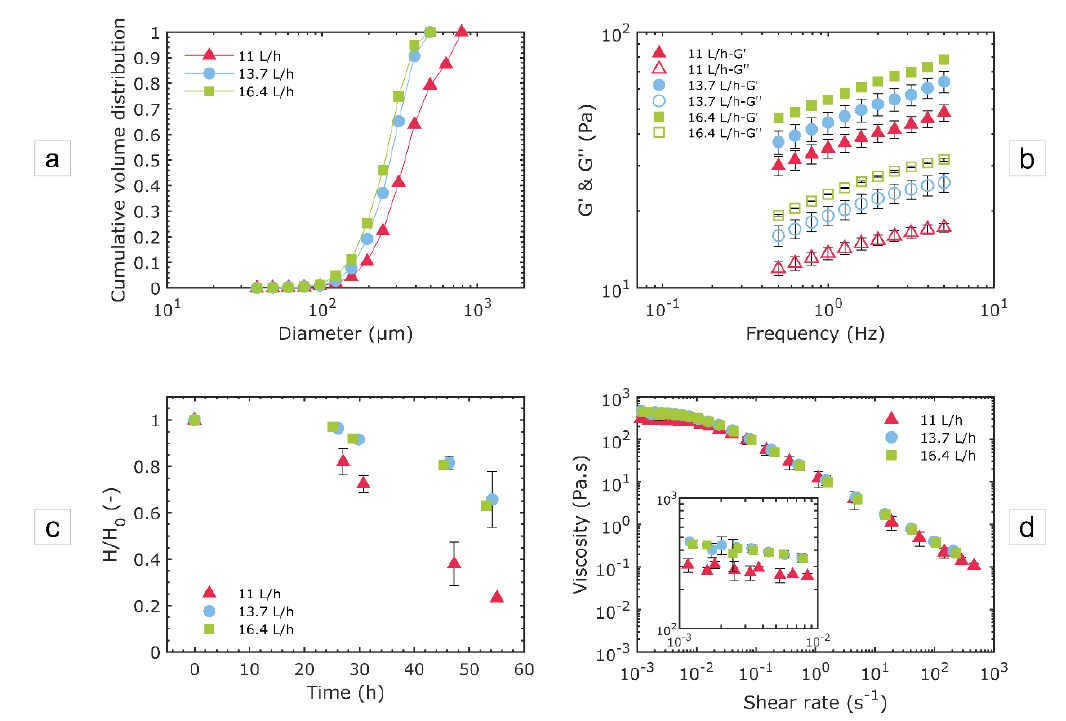
Figure 9. Effect of the liquid flowrate on the structural and usage properties of foams produced with the device CX-E-600 and the model solution WPI3XG04 at various conditions: Q vL = 11 L · h − 1 − Q mG = 21.6 g · h − 1 , Q vL = 13.7 L · h − 1 − Q mG = 23 g · h − 1 and Q vL = 16.4 L · h − 1 − Q mG = 31.0 g · h − 1 . ( a ) Bubble size distributions in the foams in cumulative volume. The diameters of bubbles inside the microchannels are normalized to the atmospheric pressure. ( b ) Mechanical moduli of foams at 20 °C. ( c ) Stability of foams. ( d ) Viscosity characterization of foams at 20 °C.